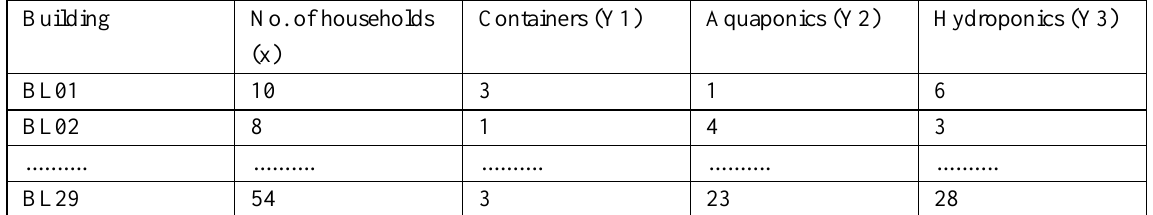
Table 1. Linear correlation coefficient of Pearson variables